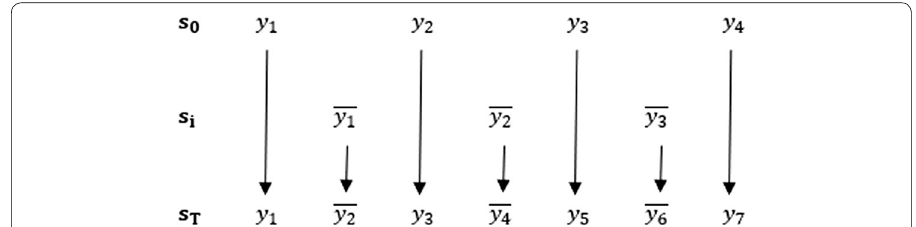
Fig. 3 Illustration of developing an audio vector comprising original and interpolating